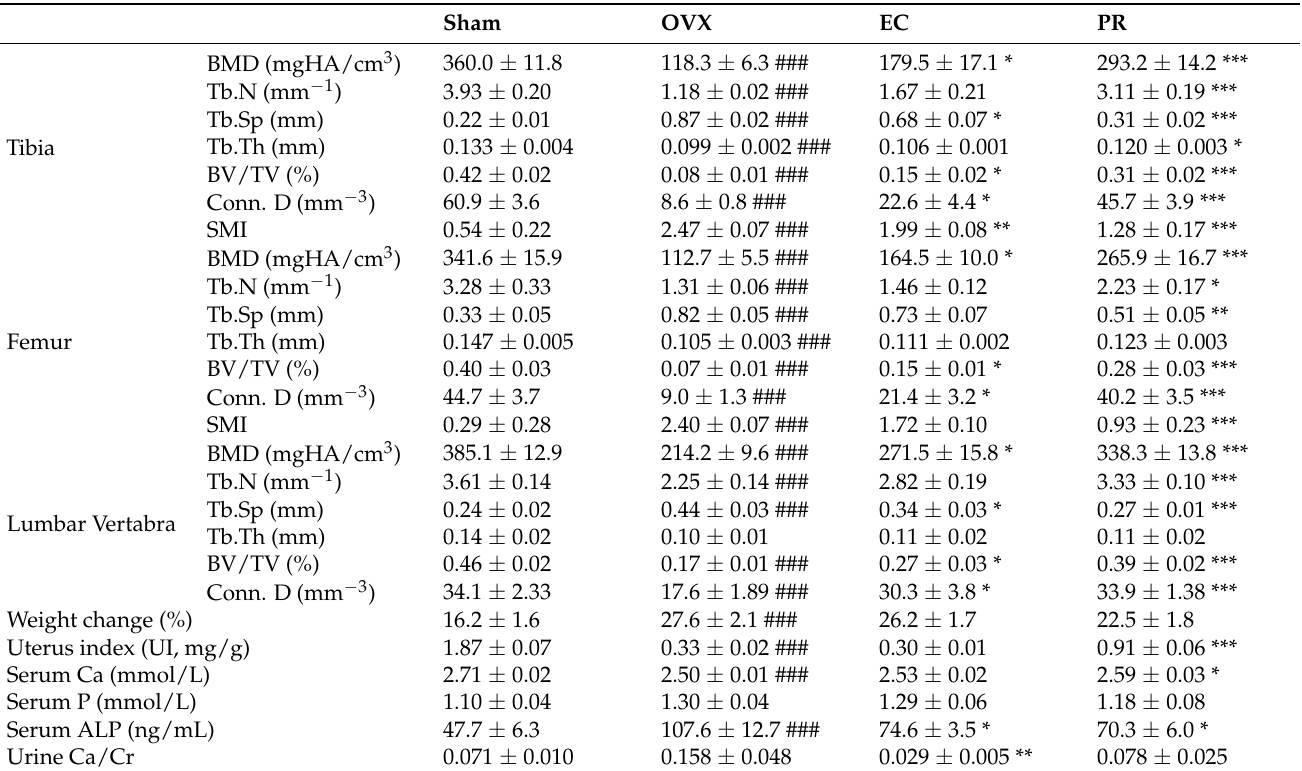
Table 2. Bone parameters, body weight changes, uterine index and levels of biochemical markers in serum and urine of